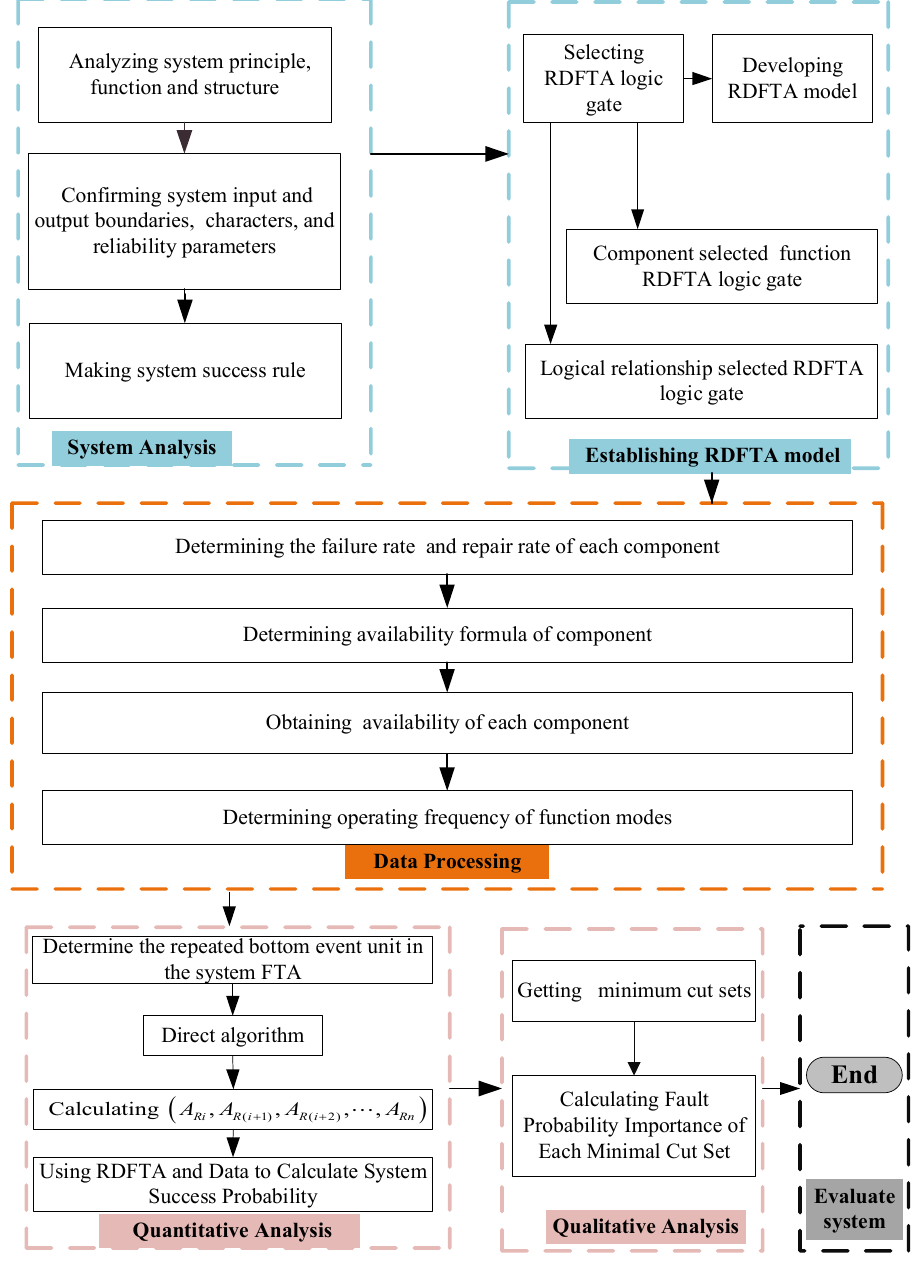
Figure 6. The reliability analysis process framework of the RDFTA method.